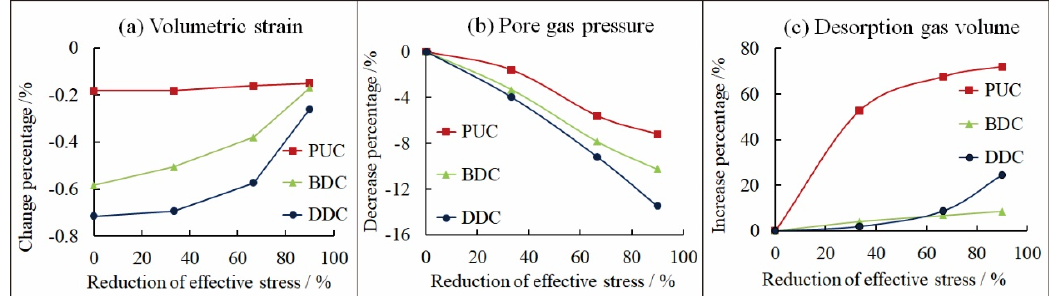
Figure 12. Changes in volumetric strain of coal core ( a ), pore gas pressure in coal core ( b ) and desorption gas volume of coal core ( c ) after decompression.